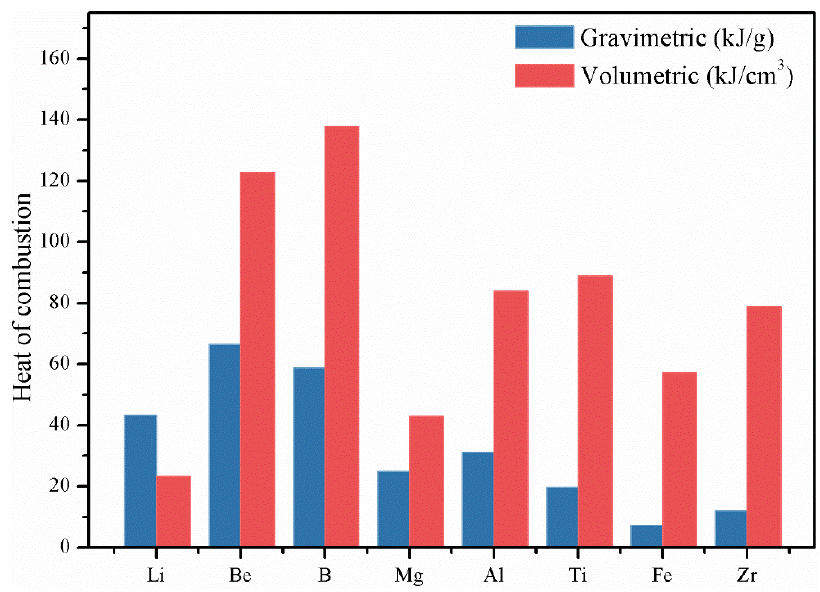
Figure 1. Gravimetric and volumetric calorific values of some metal fuels.